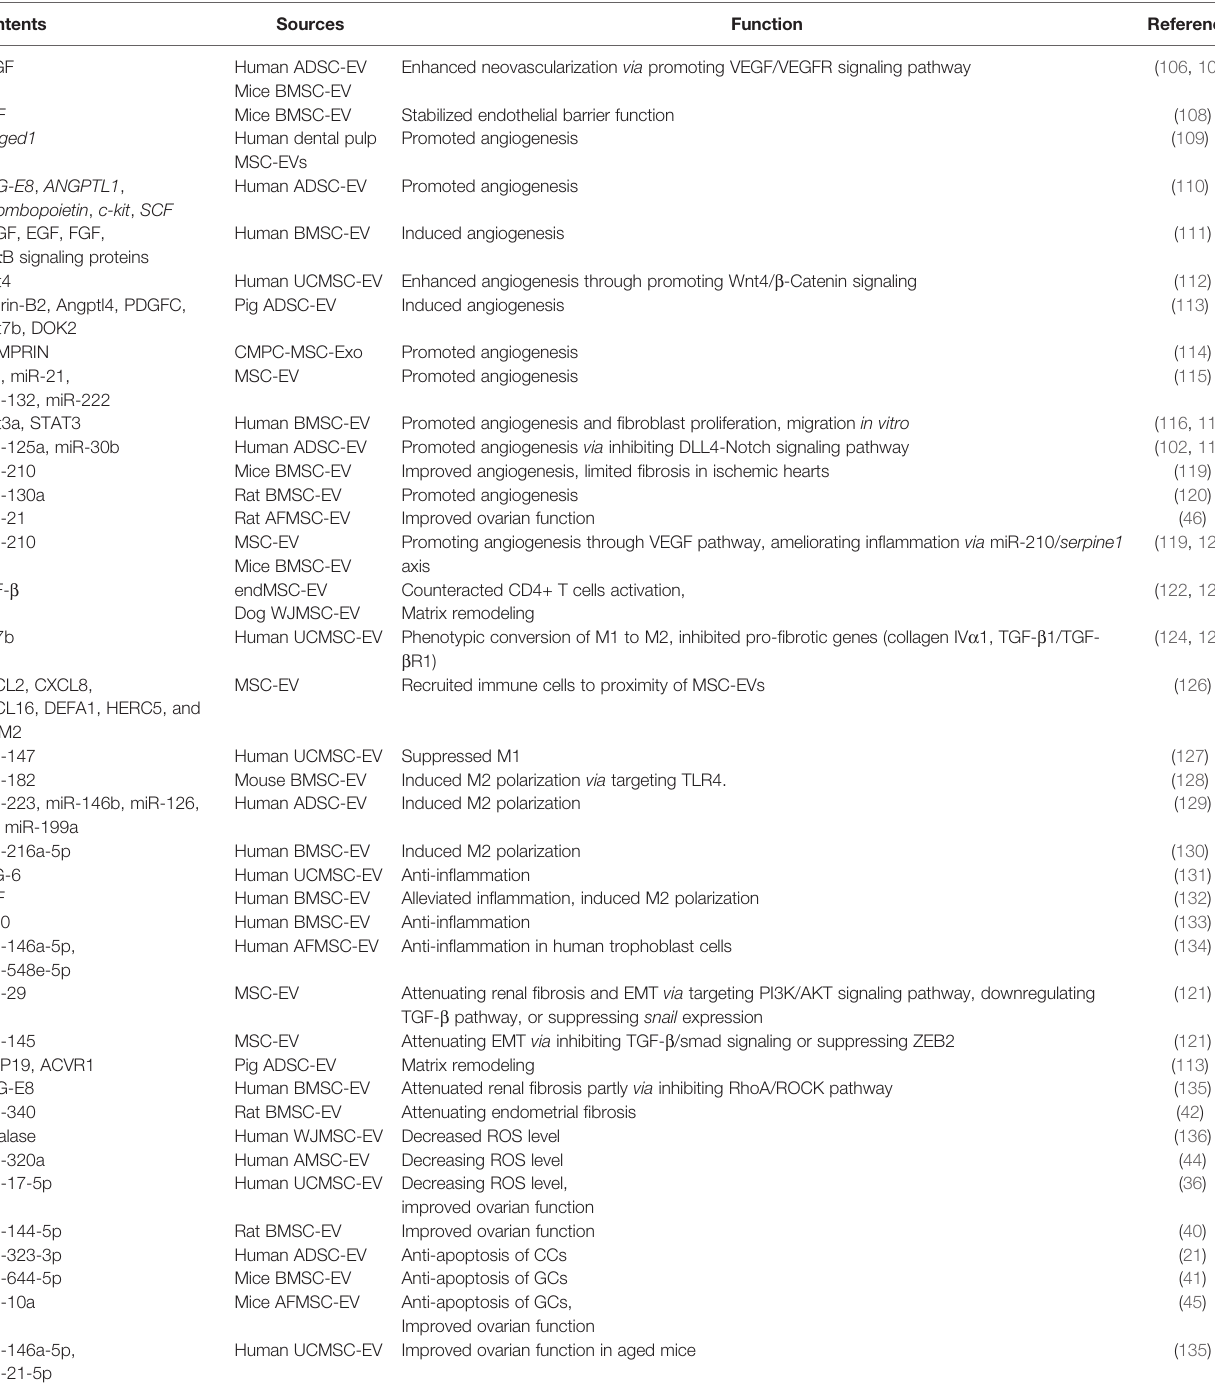
TABLE 2 | Summary of the functional contents in reported EVs derived from different